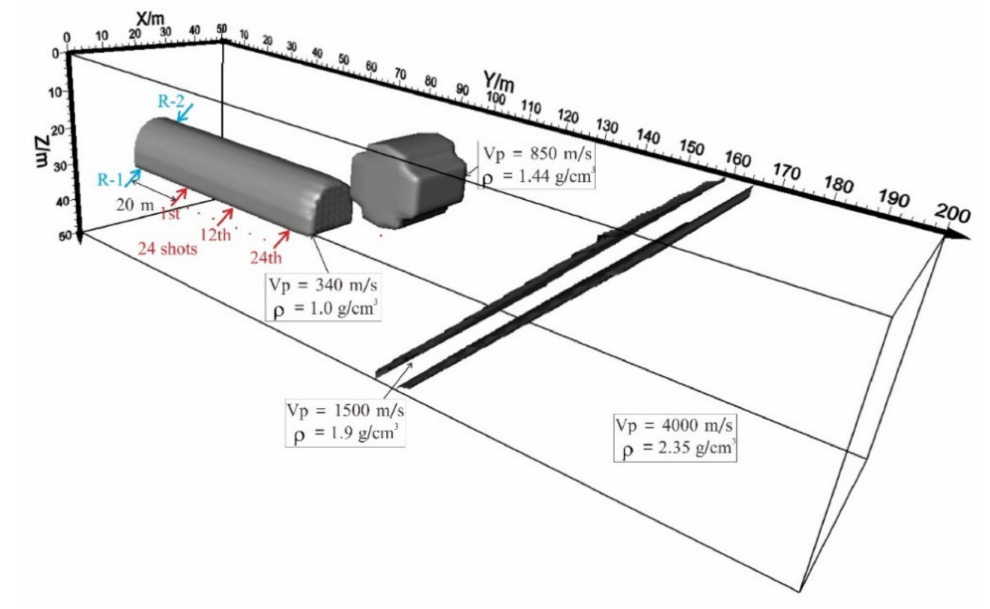
Figure 3. 3-D tunnel velocity model. R-1 and R-2 are geophone